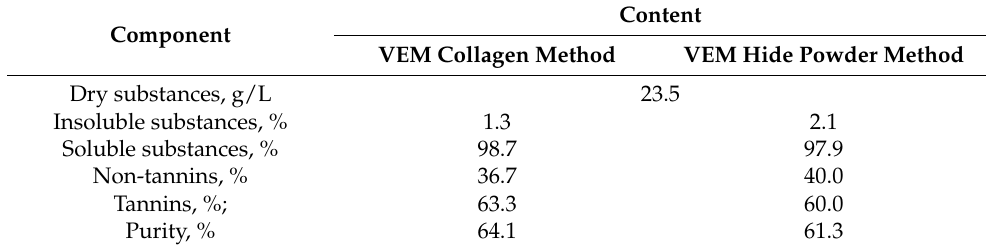
Table 7. Composition of aqueous-alkaline extract bark of Pinus sylvestris L. [107]. Component